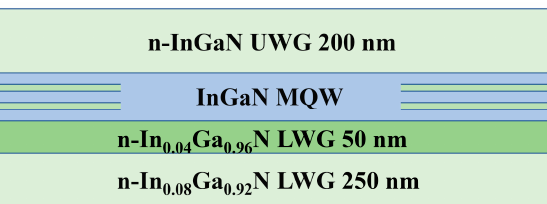
Figure 6. Schematical diagram for studied MQW and waveguide regions of a new LD structure with composite lower waveguide structure.